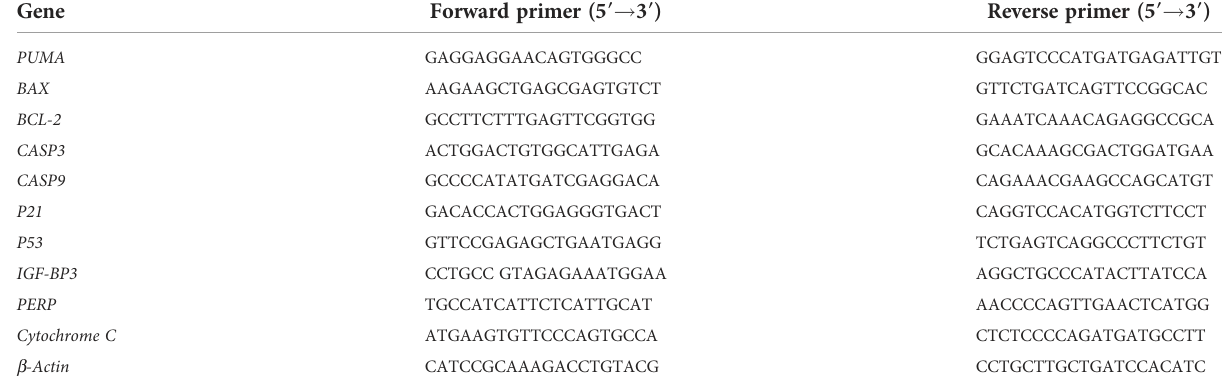
TABLE 1 PCR-ampli fi ed primer